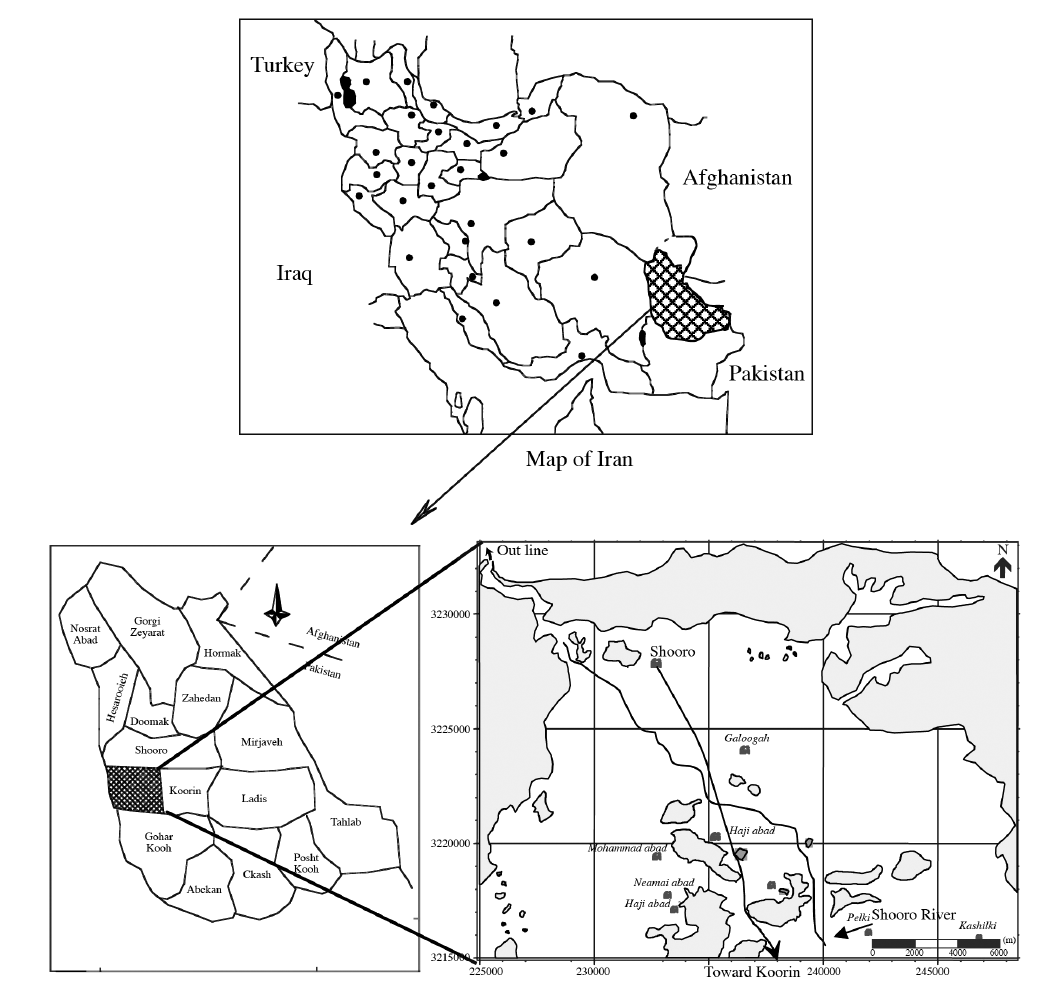
Fig. 1. Location of the studied